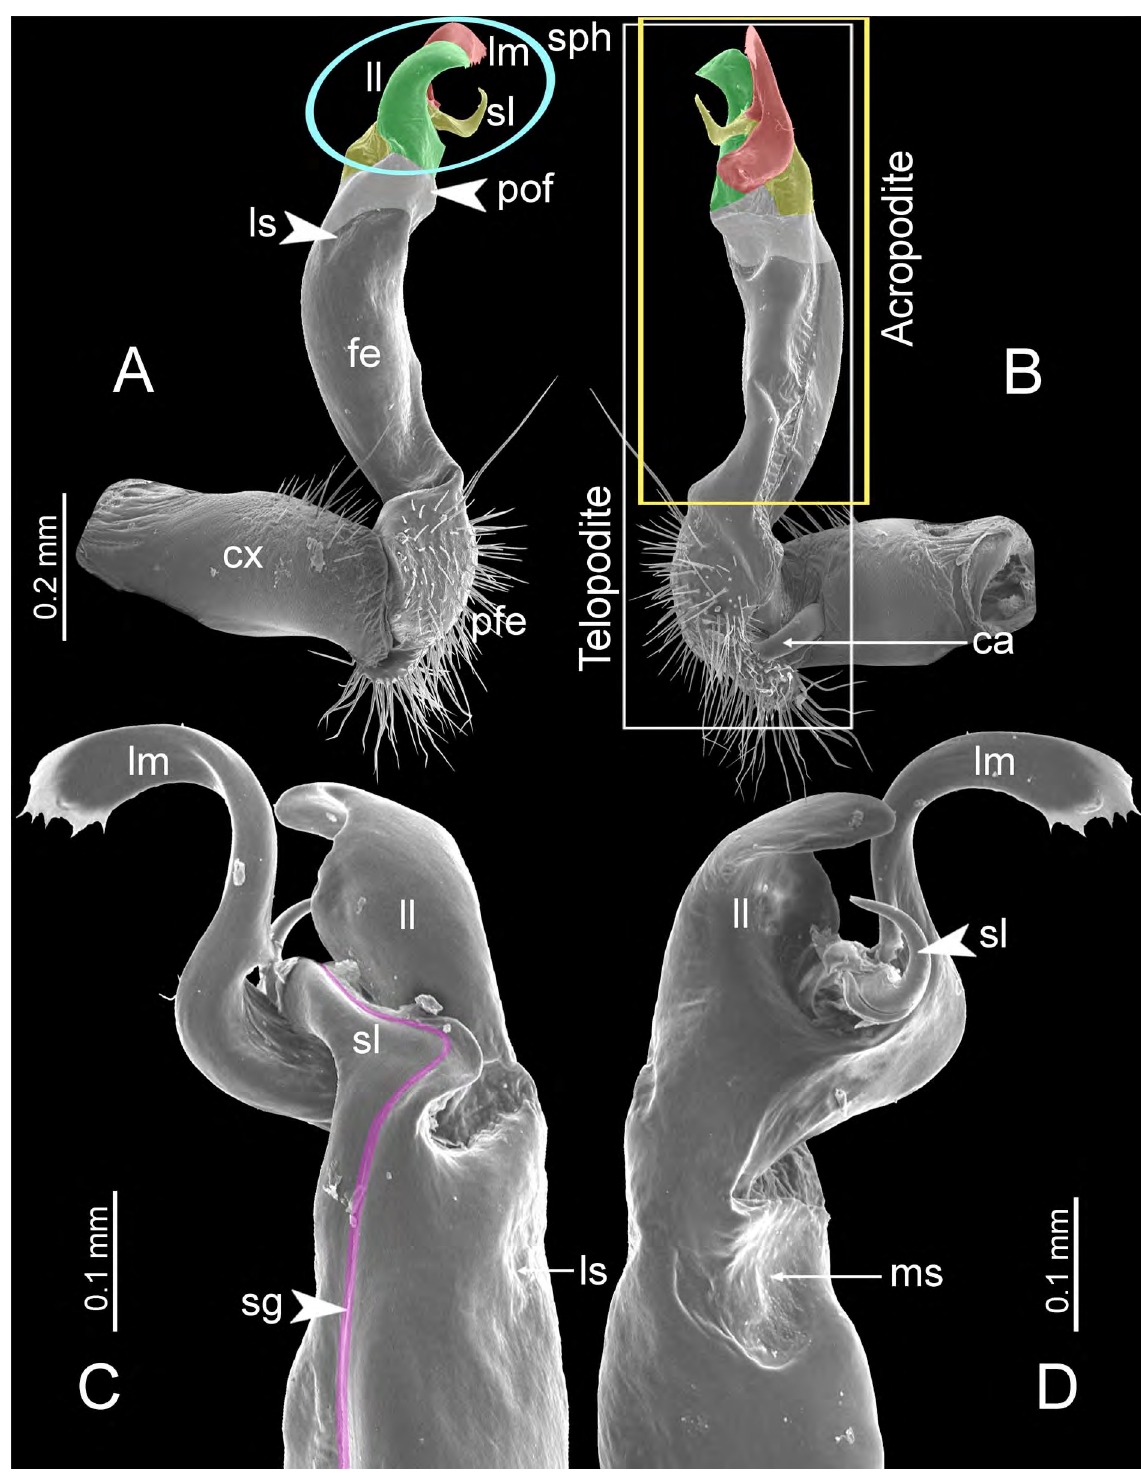
Fig. 5. SEM images of right gonopod of Nagaxytes Srisonchai, Enghoff & Panha gen. nov. – N. gracilis Srisonchai, Enghoff & Panha gen. et sp. nov., specimen from Wat Vimooddhi Wanaram, Thailand. A . Lateral view. B . Mesal view. C . Dorsal view. D . Ventral view. Colours: red = lamina medialis, green = lamina lateralis, yellow = solenomere, purple = seminal